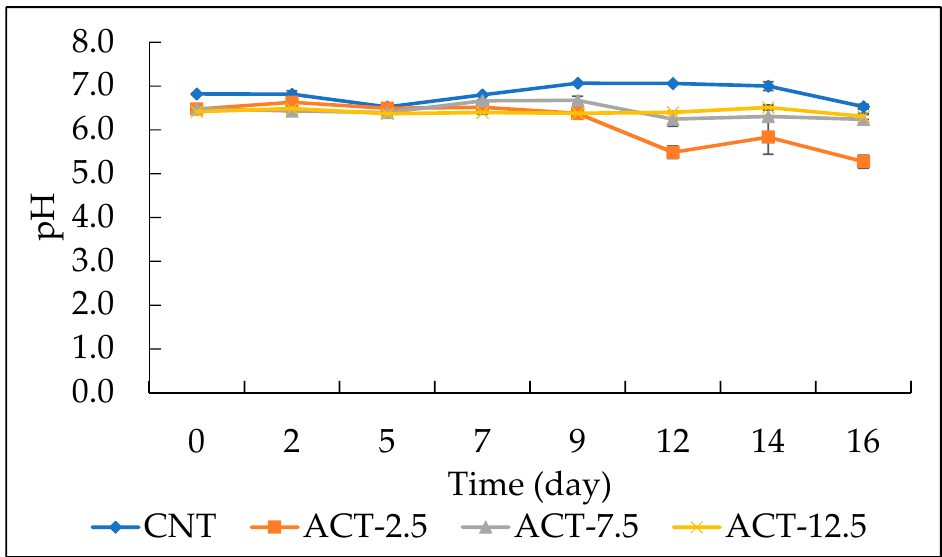
Figure 5. Trend of pH values of fish burgers during 16 days of storage at 4 °C. Data indicate means ± SD. CNT: fish burger without prickly pear powder; ACT-2.5: fish burger enriched with 2.5 g of prickly pear powder; ACT-7.5: fish burger enriched with 7.5 g of prickly pear powder; ACT-12.5: fish burgers enriched with 12.5 g of prickly pear